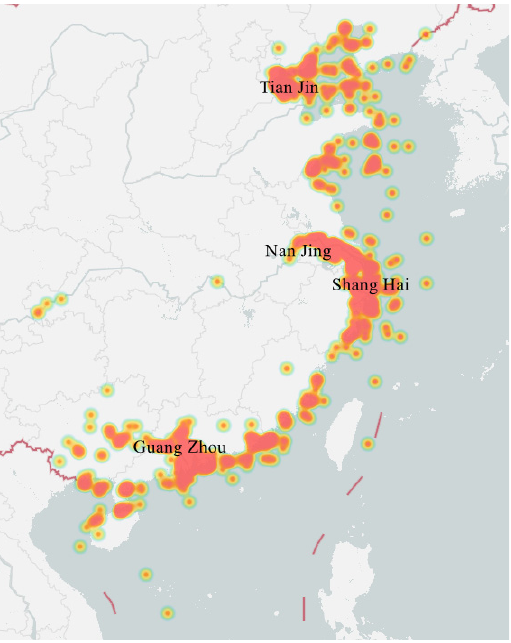
Figure 1. Heat map of the locations of maritime accidents along the Chinese coastline.